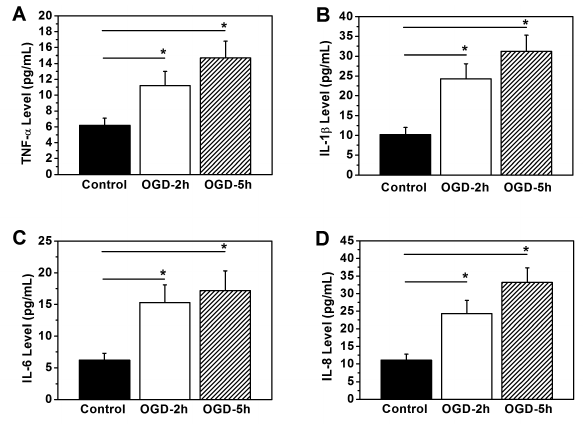
Figure 2. Secretion of proinflammatory factors from microglia cells under OGD treatment. Compared to the control group, levels of TNF-α (A), IL-1β (B), IL-6 (C) and IL-8 (D) were markedly increased by OGD-induced damage either for 2 h or 5 h. Data were presented as mean ± S.E.M. *p < 0.05 vs